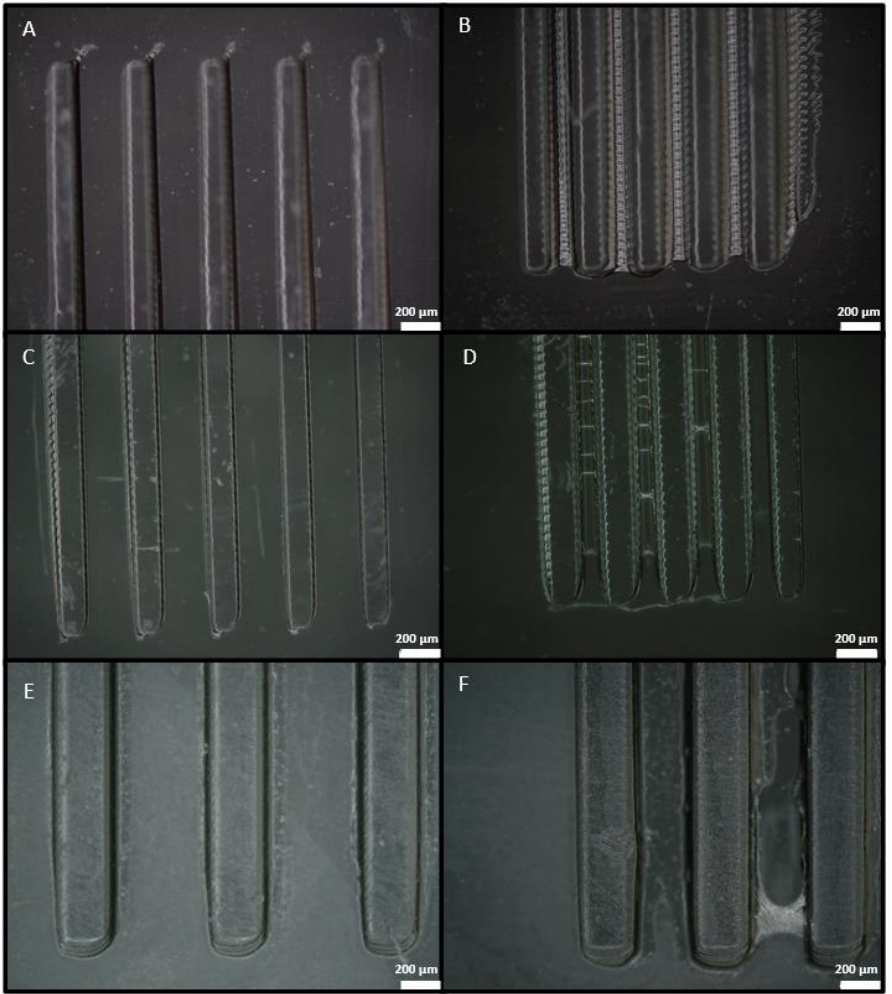
Figure 6. ( A ) Picture of the part printed with Detax, with a designed height of 200 µ m, a width of 100 µ m with a separation of 300 µ m. ( B ) Picture of the part printed with Detax, with a designed height of 200 µ m, a width of 100 µ m with a separation of 200 µ m. ( C ) Picture of the part printed with Asiga, with a designed height of 200 µ m, a width of 100 µ m with a separation of 300 µ m. ( D ) Picture of the part printed with Asiga, with a designed height of 200 µ m, a width of 100 µ m with a separation of 200 µ m. ( E ) Picture of the part printed with Keyprint, with a designed height of 400 µ m, a width of 200 µ m with a separation of 600 µ m. ( F ) Picture of the part printed with Keyprint, with a designed height of 400 µ m, a width of 200 µ m with a separation of 400 µ m. The figures in ( A , C , E ) are the ones obtained with the minimum height for each resin, the width being half the weight and the separation being three times the width and with a correct definition. The figures in ( B , D , F ) are the ones obtained with the minimum height for each resin, the width being half the weight and the separation being two times the width, and it can be appreciated that the separation of the structures starts being imperfect. The scale bar for all figures is 200 µm.